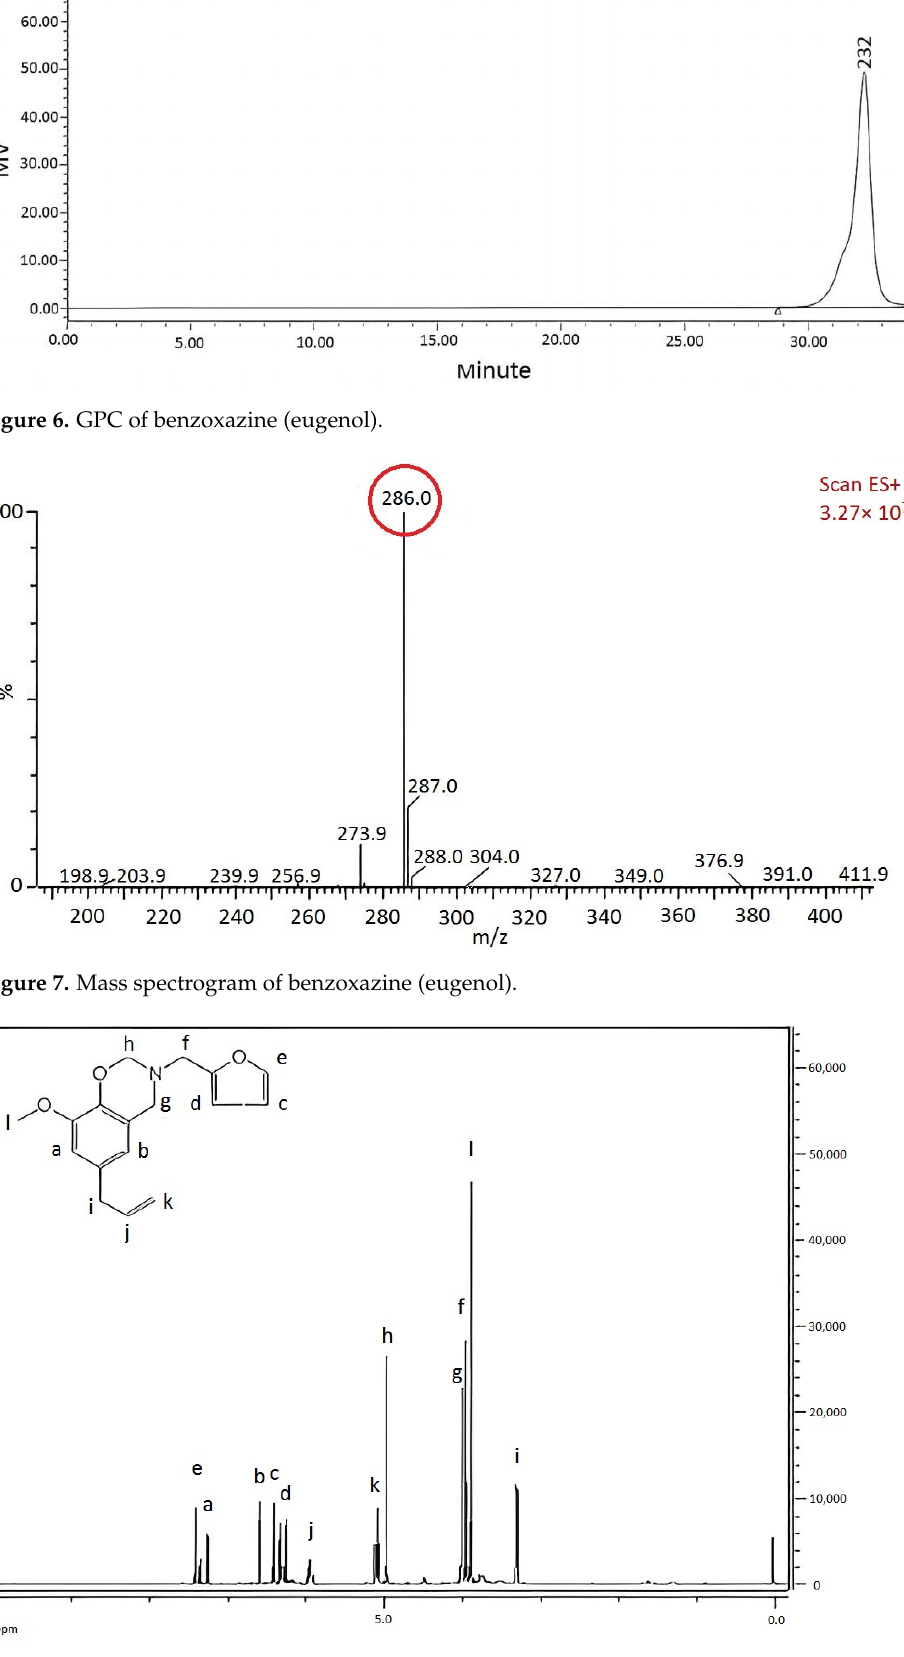
Figure 8. 1 H ‐ NMR spectrum of benzoxazine (eugenol) . Figure 8. 1 H-NMR spectrum of benzoxazine